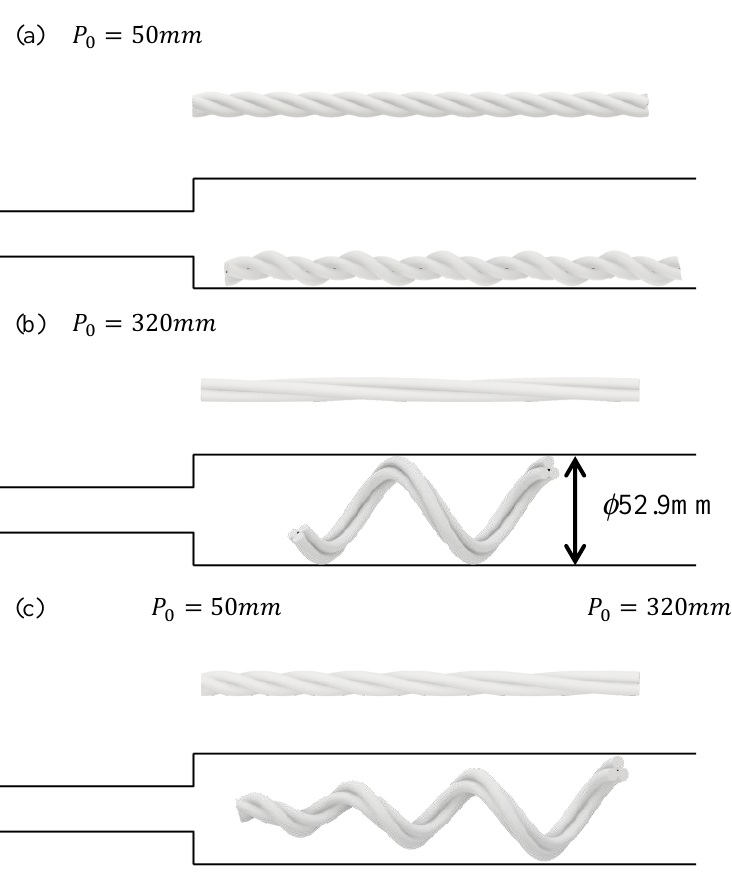
Figure 6. Initial shape and deformed shape when α = 1.11, where ( a – c ) show devices whose initial pitches are 50 mm, 320 mm, and biased,